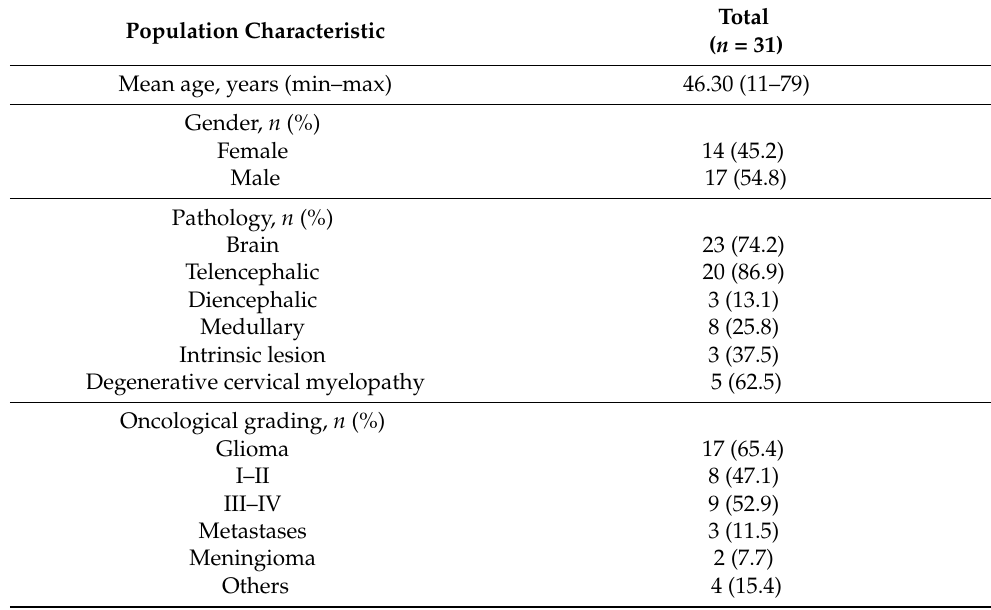
Table 1. Overview of the whole patient sample and